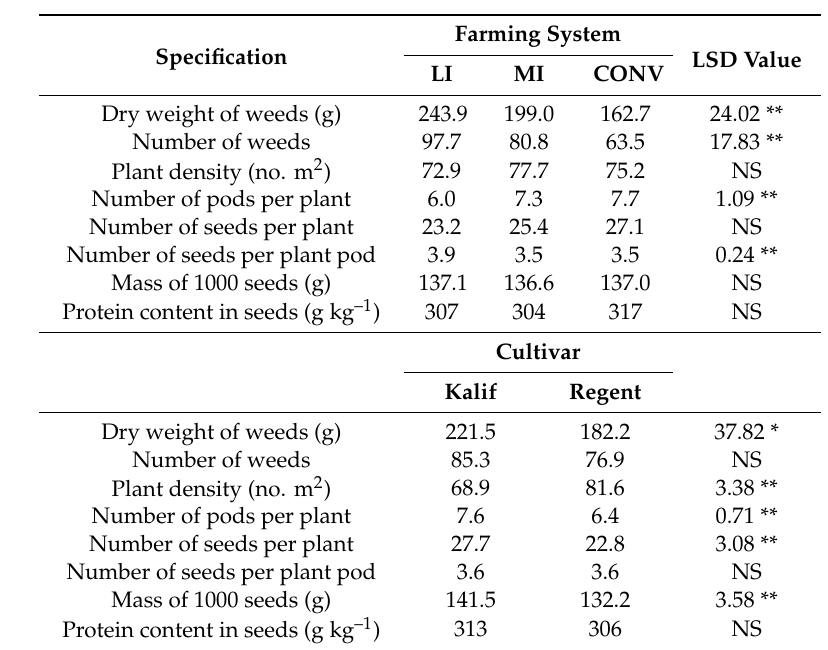
Table 3. E ff ect of farming system on botanical composition of weeds in the study plots (share, %). Farming System Latin Binomial Bayer Code LI MI CONV Agropyron repens (L.) Beauv. AGRRE 4 2 0 Anchusa arvensis L. LYCAR 1 0 1 Capsella bursa-pastoris (L.) Medik. CAPBP 1 0 0 Chenopodium album L. CHEAL 27 31 32 Convolvulus arvensis L. CONAR 0 0 1 Echinochola crus-galli (L.) Beauv. ECHCG 4 8 11 Galinsoga parviflora Cav. GASPA 2 3 0 Galium aparine L. GALAP 1 1 0 Lamium amplexicanle L. LAMAM 1 0 1 Polygonum convolvules (L.) A. Löve POLCO 49 46 43 Polygonum lapathifolium L. POLLA 5 1 6 Viola arvensis Murr. VIOAR